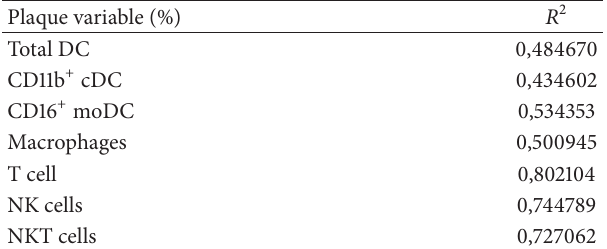
Table 5: Coefficient of determination ( 𝑅 2 ) values for each of the plaque variables calculated from a multiple linear regression model with all the risk factors and blood parameters as independent variables ( 𝑛 = 57 plaque and blood samples). This is the amount of variance in the outcome (plaque variable) that can be explained by all the risk factors and blood variables